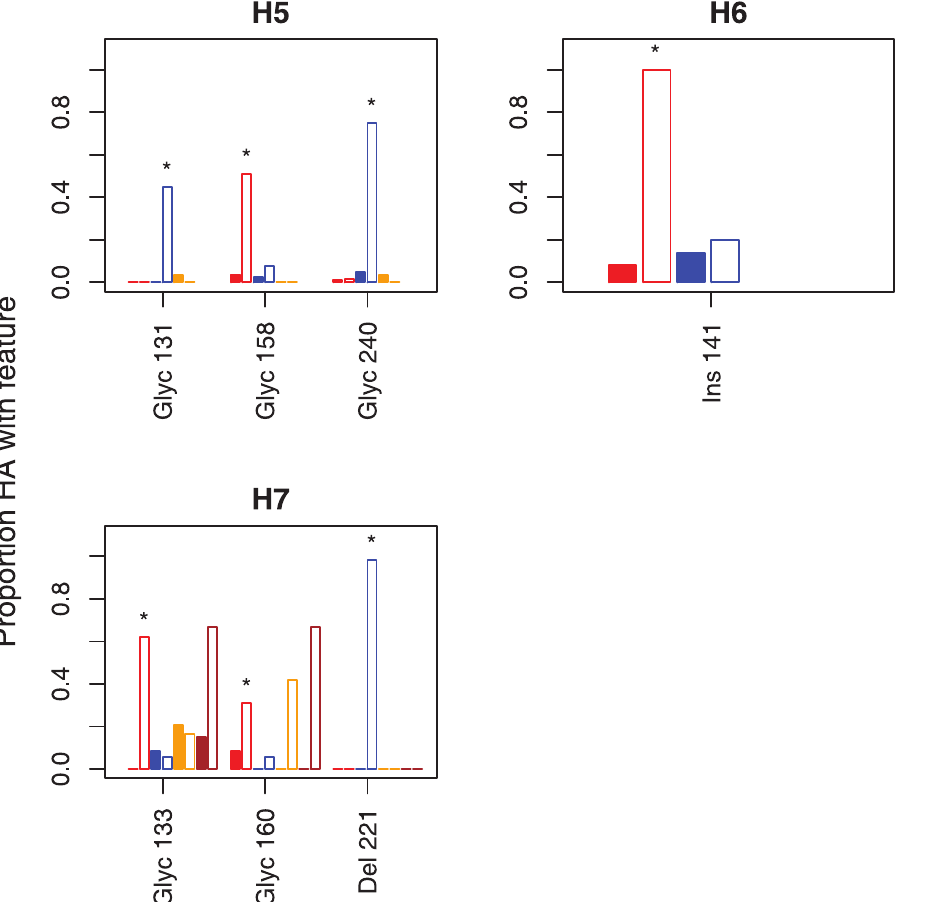
Figure 4. Proportions of HA protein features among viruses with full-length-NA (filled bars) or with S D NA (open bars). The X-axis indicates the features, where Glyc denotes a glycosylation site, Del denotes a deletion, Ins denotes an insertion and the number indicates the amino acid position according to the H3 numbering. NA subtypes are color-coded (red = N1, blue = N2, orange = N3, brown = N7). Asterisks denote HA features whose S D NA are statistically correlated with the HA feature since the posterior probability that D Q exceeds zero is greater than 0.95 (refer to Methods and Table 4).